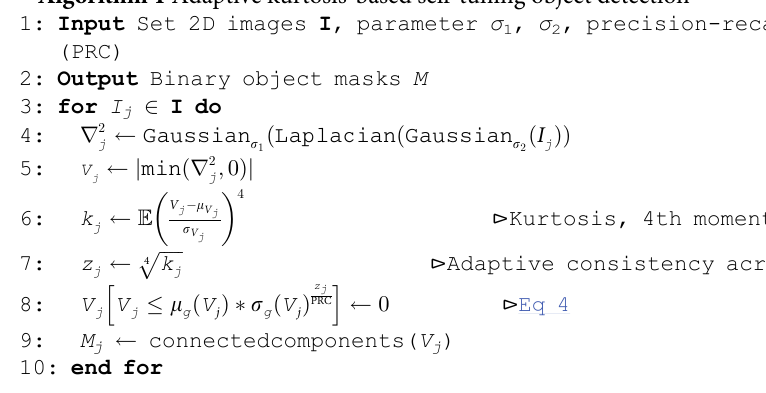
Algorithm 1 Adaptive kurtosis-based self-tuning object